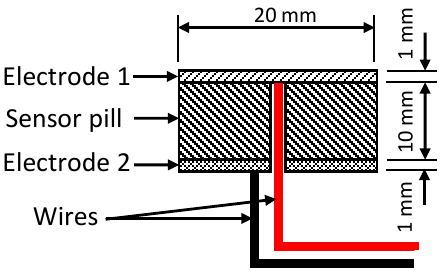
Figure 13. Electrode design of the sensor.